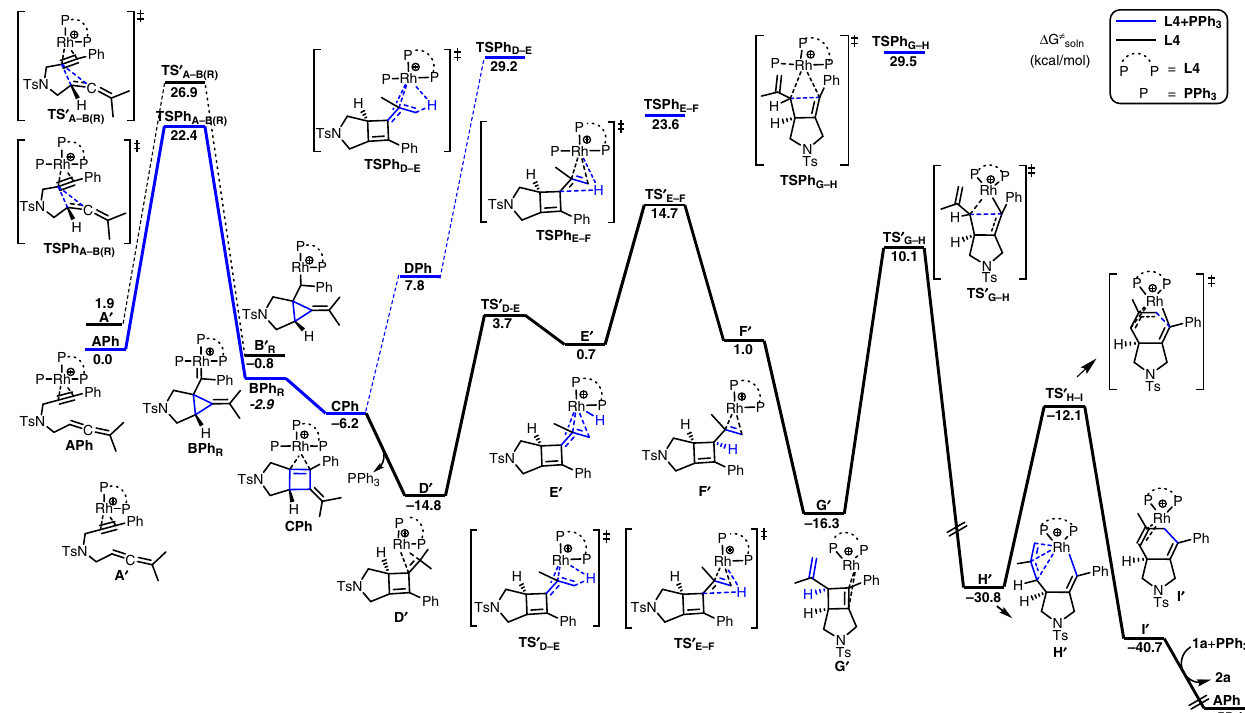
Fig. 3 DFT Results. The computed free energy pro fi les for the most possible pathway ( i-Ph ) of the Rh(I)-catalyzed cycloisomerization of 1,6-allenyne ( 1a ) in solution by SMD M06-L//M06-L method